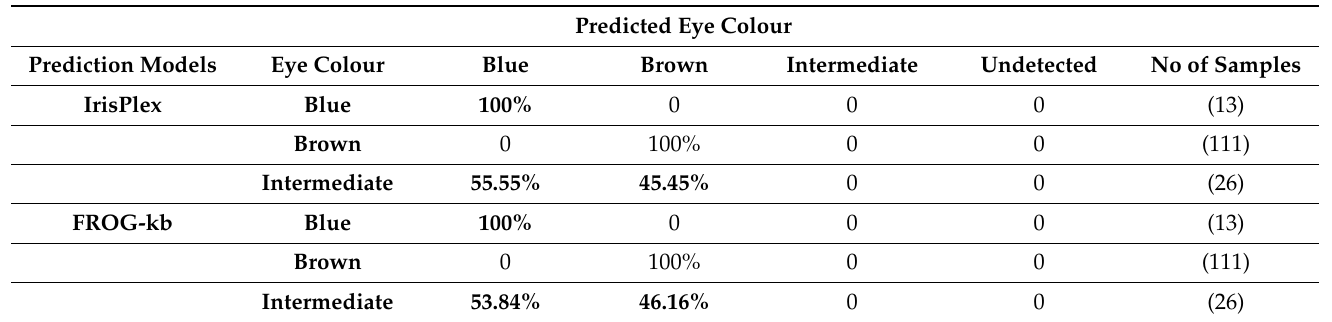
Table 6. Eye colour prediction model validation: Bold values show successful prediction estimates from the local resident Pakhtoon population.